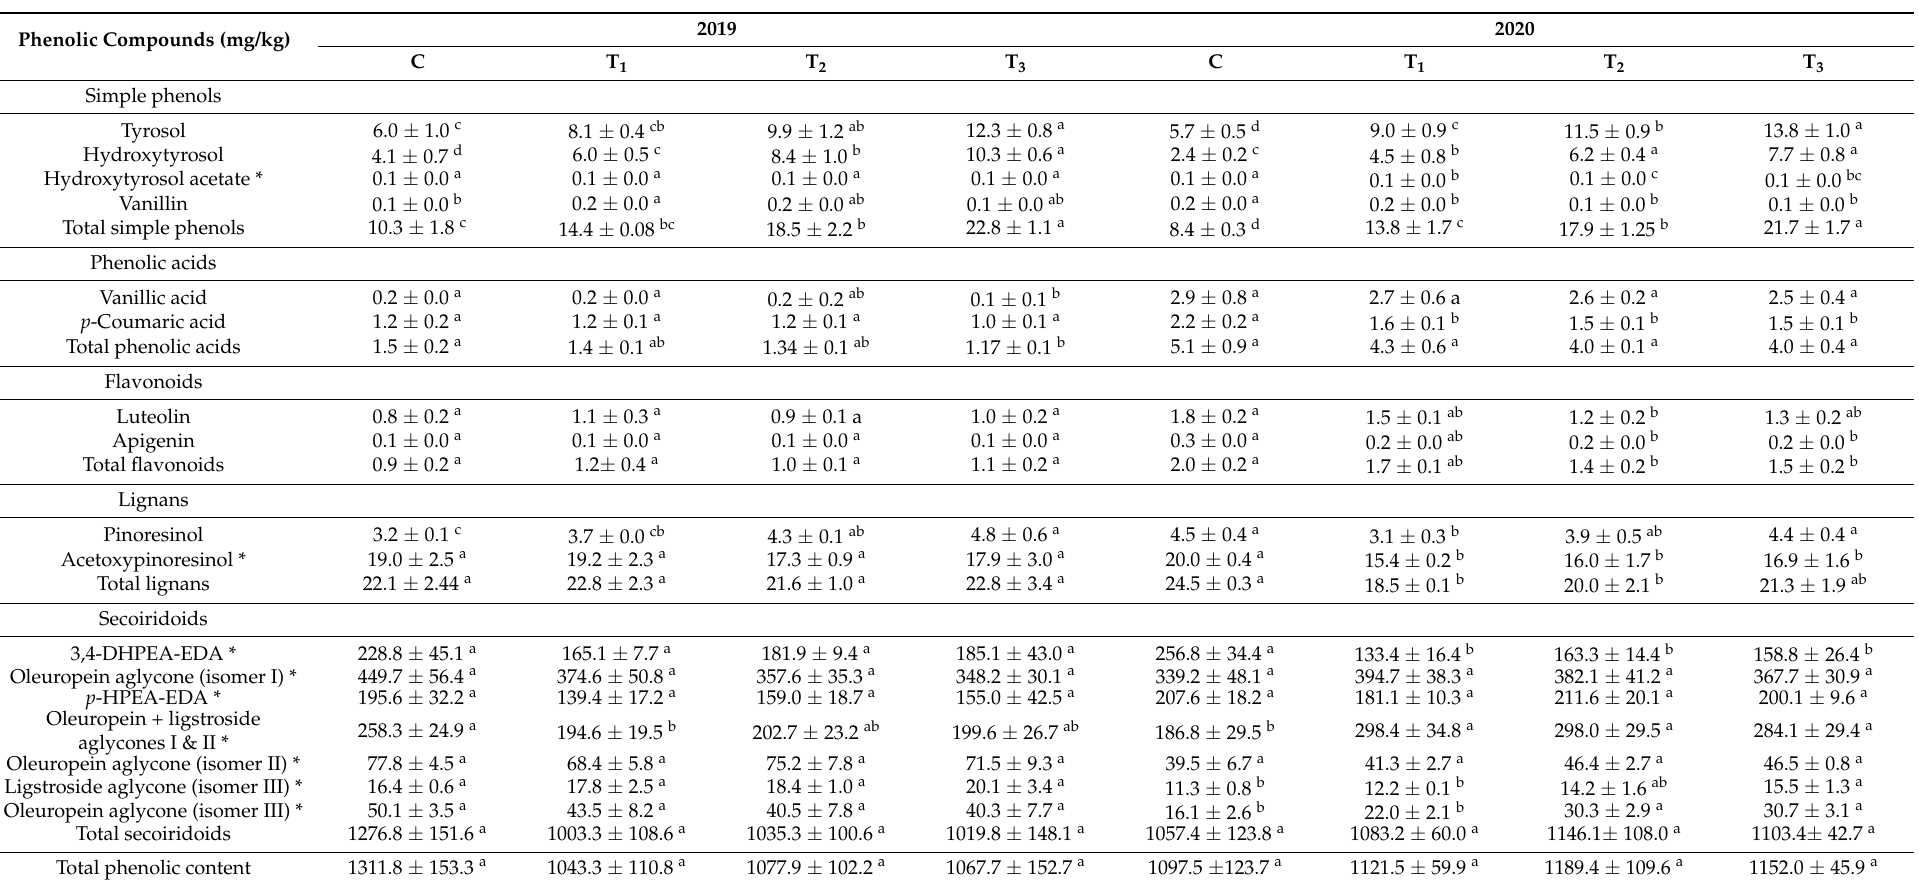
Table 7. Concentration of phenolic compounds of virgin olive oils from Coratina cv. olive trees grown under different watering regimes during two crop seasons (2019 and